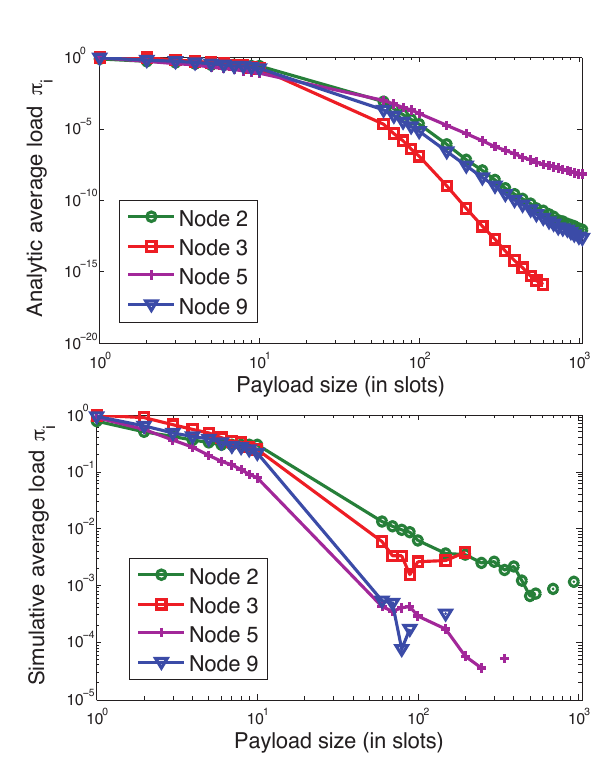
Figure 8. Average load of forwarding queues from model versus simulation when varying the payload size.